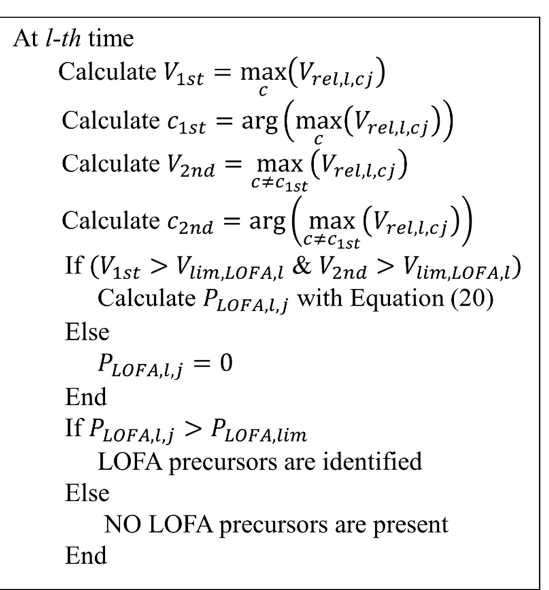
Figure 5. Flow chart of the OSSC procedure.